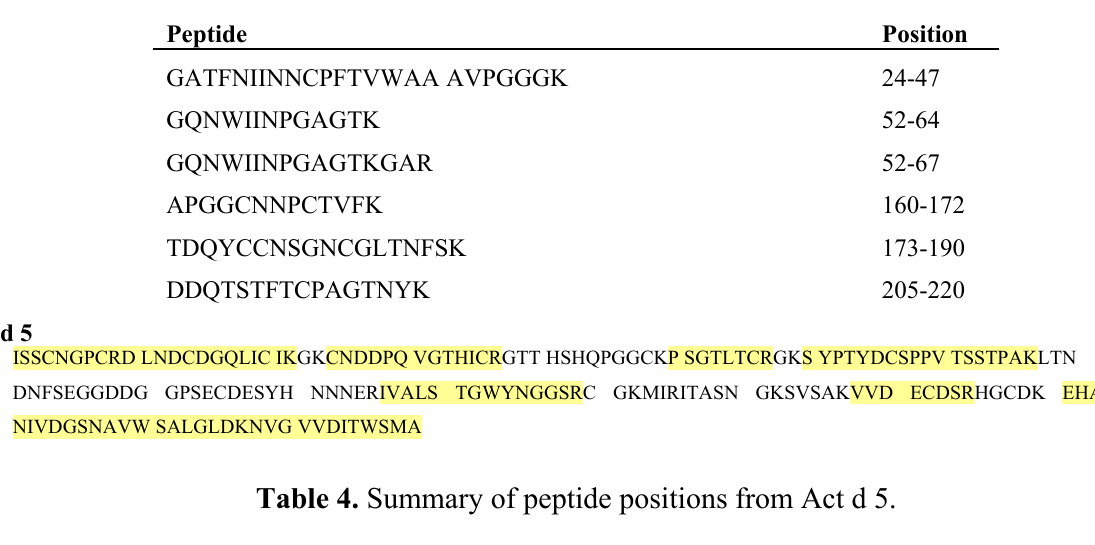
Table 3. Summary of peptide positions from Act d 2.